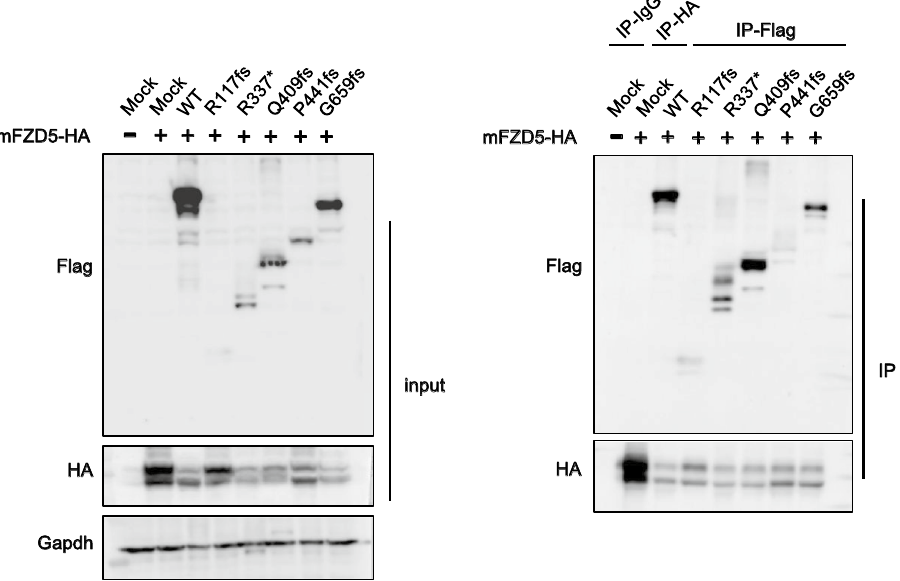
Figure 5. Co-immunoprecipitation of RNF43 and its mutants with FZD5. HEK293 cells were transfected with the indicated constructs and immunoprecipitated with control IgG or FLAG antibody. Immunoprecipitation and total cell lysates were immunoblotted with the indicated antibodies.